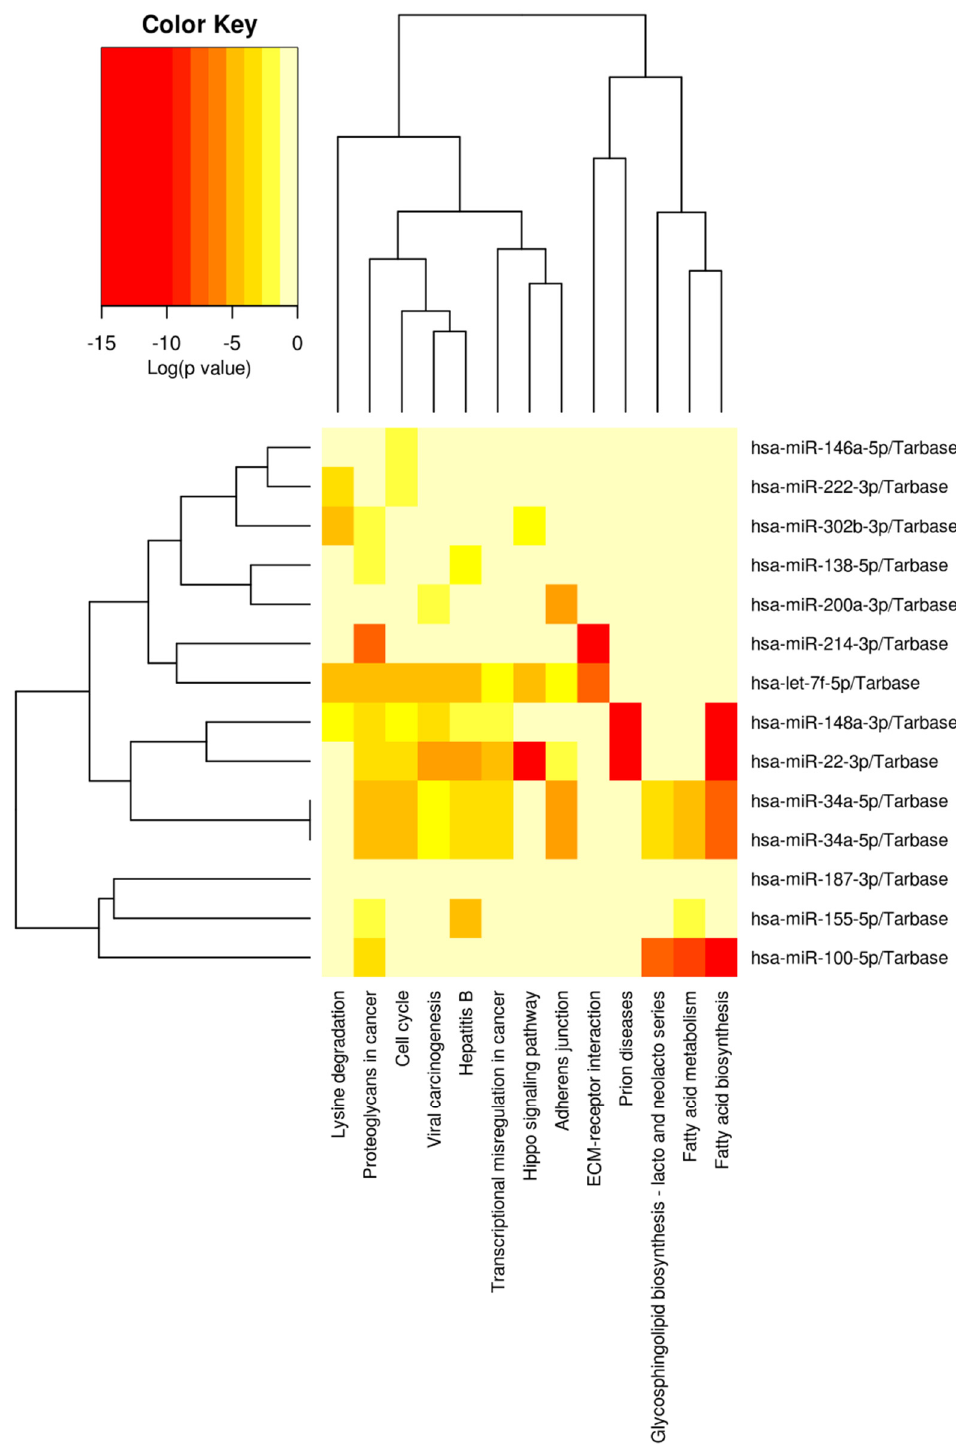
Figure 1. DIANA miRPath [18] KEGG analysis results identified several pathways that may be related to recurrence in bladder cancer. Relevant pathways, based on predicted gene targets of these miRNAs, include proteoglycans in cancer (92 genes), Hippo signaling (49 genes), cell cycle (69 genes), adherens junctions (32 genes), ECM receptor-interaction (15 genes), fatty acid metabolism (14 genes), and fatty acid biosynthesis (4 genes).